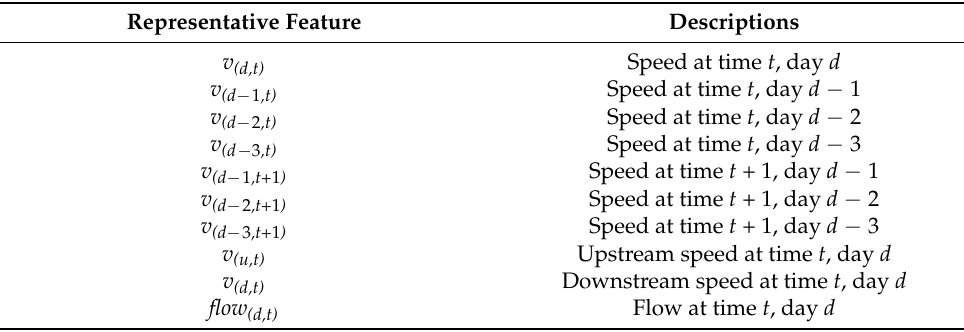
Table 1. Constructed feature candidates for the prediction model. Representative